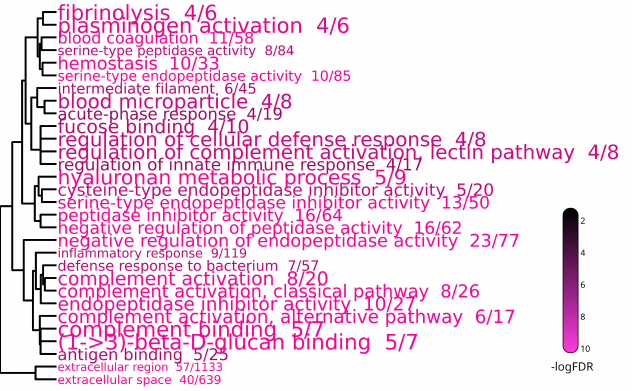
Figure 2. Dendrogram representation of complete linkage of overlapping DEGs associated with the top 30 most significantly enriched GO terms in the Stressed vs. Control comparison of the Brain sample at T2. The size of the GO terms codes for the observed/expected value, the color scale for statistical